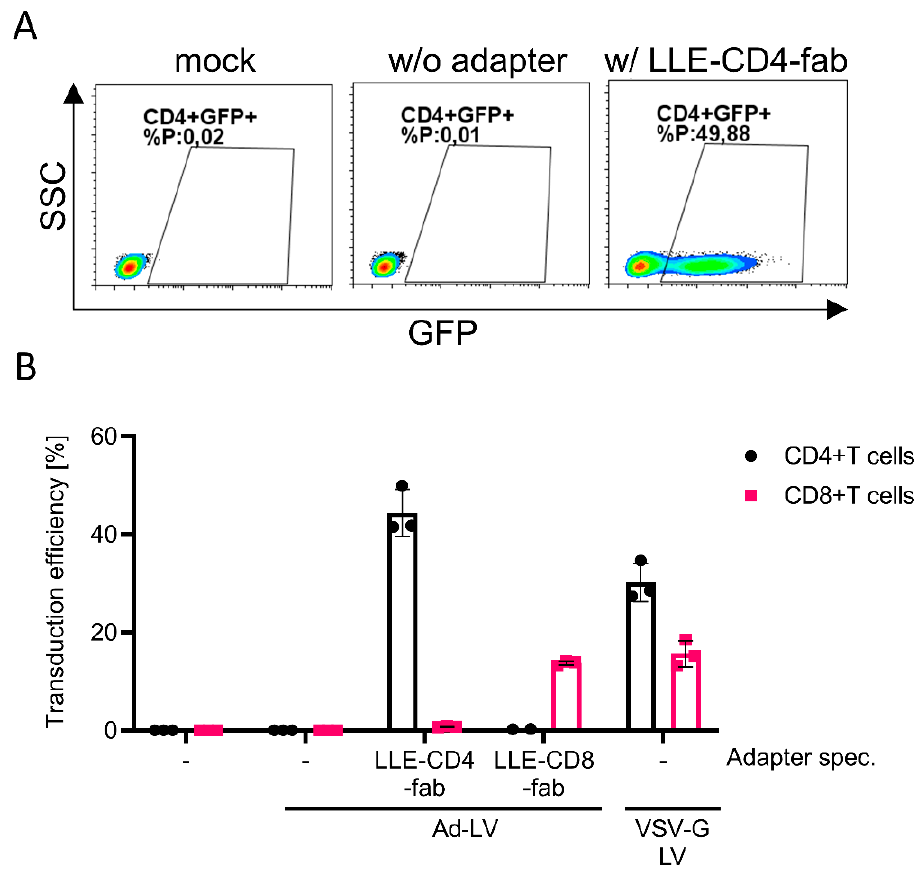
Figure 6. Selective transduction of activated murine T cells. Murine T cells were isolated from murine spleens, activated overnight, and transduced using Ad-LVs at a dose of 5 TU/cell. ( A ) Representative data are shown of CD4+ T cells transduced in the absence of adapter or in the presence of LLE-CD4 fab. ( B ) Isolated murine T cells from spleen were either left untreated (-) or transduced with Ad-LVs in the absence of adapter (-) or in the presence of LLE-CD4 fab (clone: GK1.5) and LLE-CD8 fab (clone: 53–6.7)-specific adapter molecules (500 ng/mL). VSV-G LVs were used as positive controls. Data are represented as mean ± SD of 3 different mice.